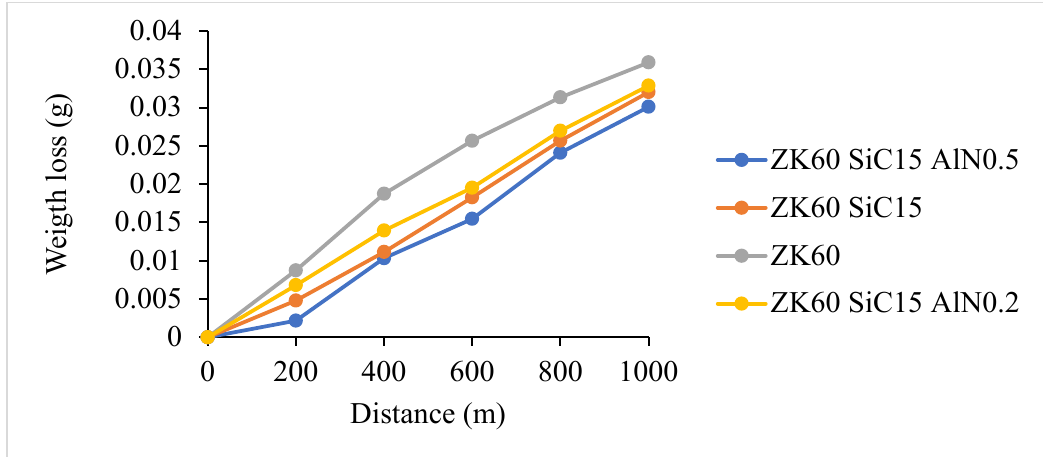
Figure 11. The comparisons of the maximum compressive strengths.